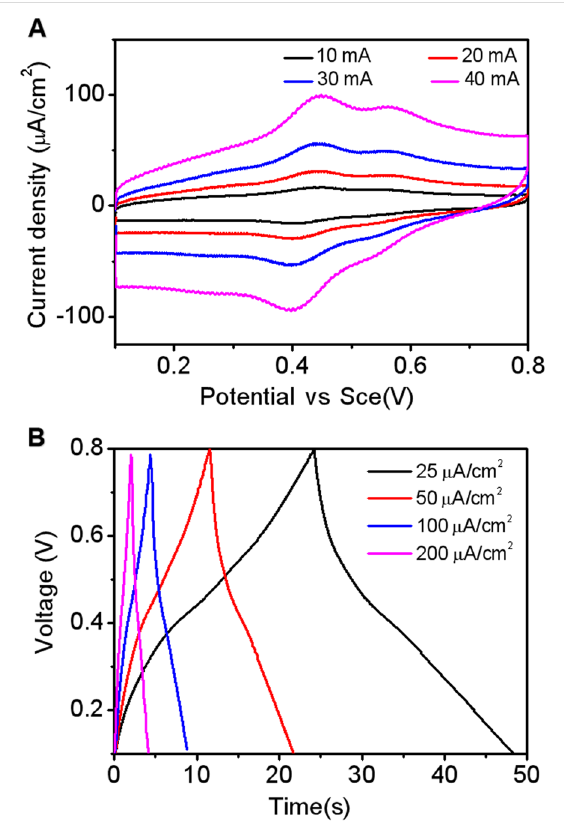
Figure 4: Characterization of hydrogels as supercapacitors. (A) Cyclic voltammograms at different scan rates. (B) Galvanostatic charge–dis- charge curves of C-WY hydrogels at different current